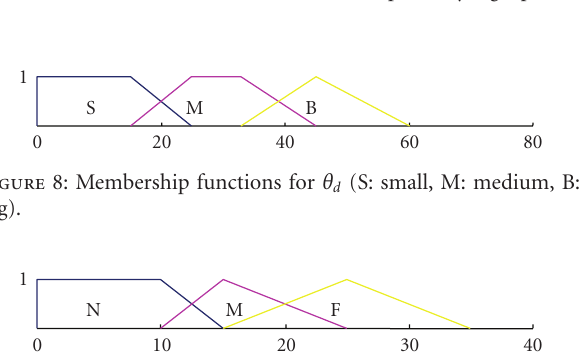
Figure 7: Multiple fuzzy logic probability evaluator for collision type detection.